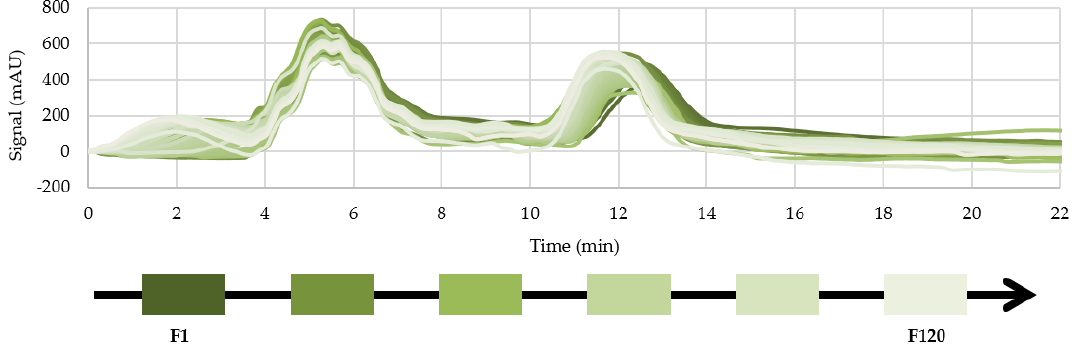
Figure 12. Chromatograms of the 120 runs with an injection volume of 10 mL at 254 nm.